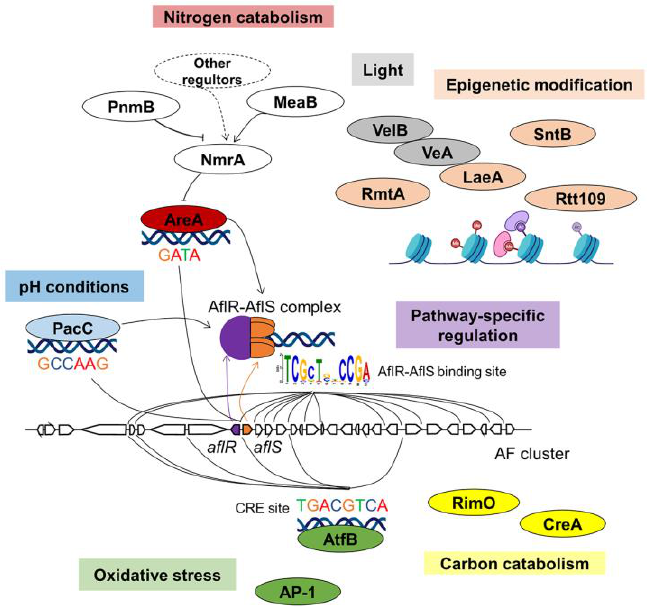
Figure 2. Regulatory mechanism of AF biosynthesis. PAT is produced by several fungal genera, including Penicillium , Aspergillus and Byssochlamys [82]. The pat BGC contains 15 genes, including a Zn(II) 2 Cys 6 TF gene patL . PatL is found to be localized in the nucleus and acts as a pathway-specific regulator in P. expansum (Figure 3) [44,83]. No PAT was detected in a ∆ patL mutant, and the pat genes were only marginally expressed in the ∆ patL mutant [44]. The regulatory mechanism of how PatL regulates each pat gene is yet to be investigated but presumably will be operated similarly as AflR by binding to a specific motif in the promoters of other pat